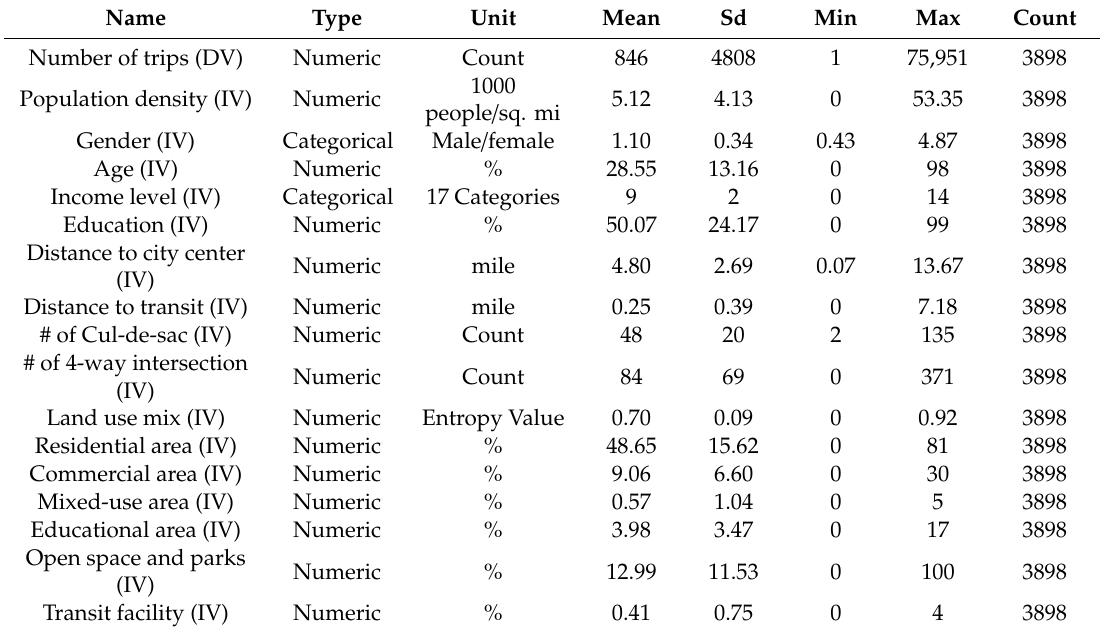
Table 2. Descriptive statistics of dependent (DV) and independent variable (IV) for the NB